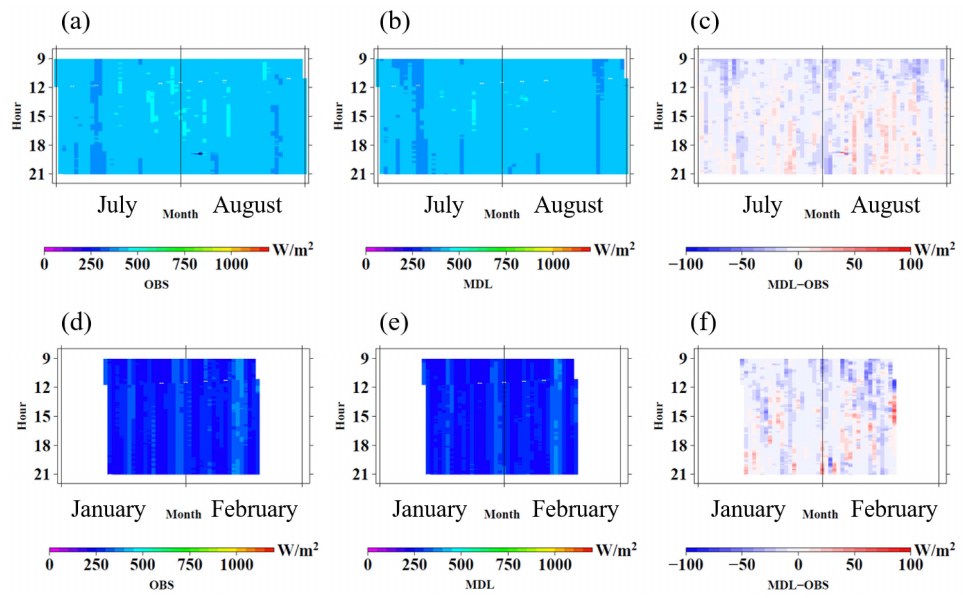
Figure 11. Same as Figure 10, but for DLW.